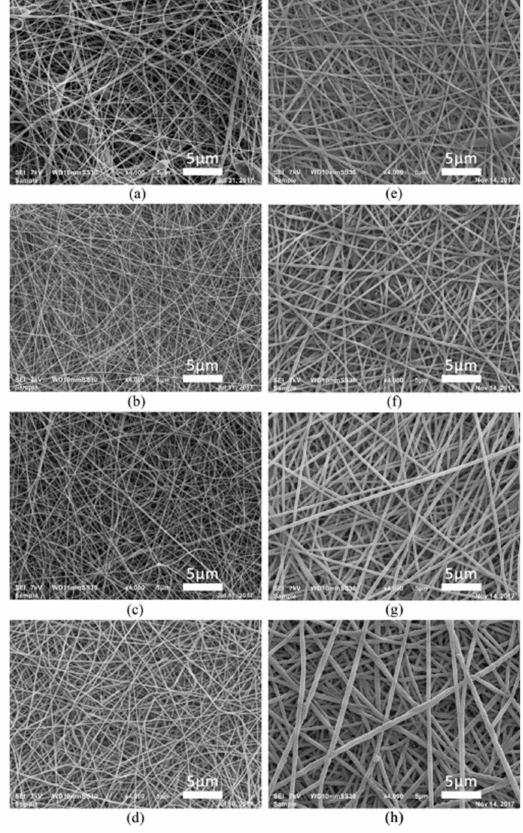
Figure 1. SEM images of ( a ) untreated and ( b – h ) PPF-NFs with various deposition durations: ( b ) 10 s,